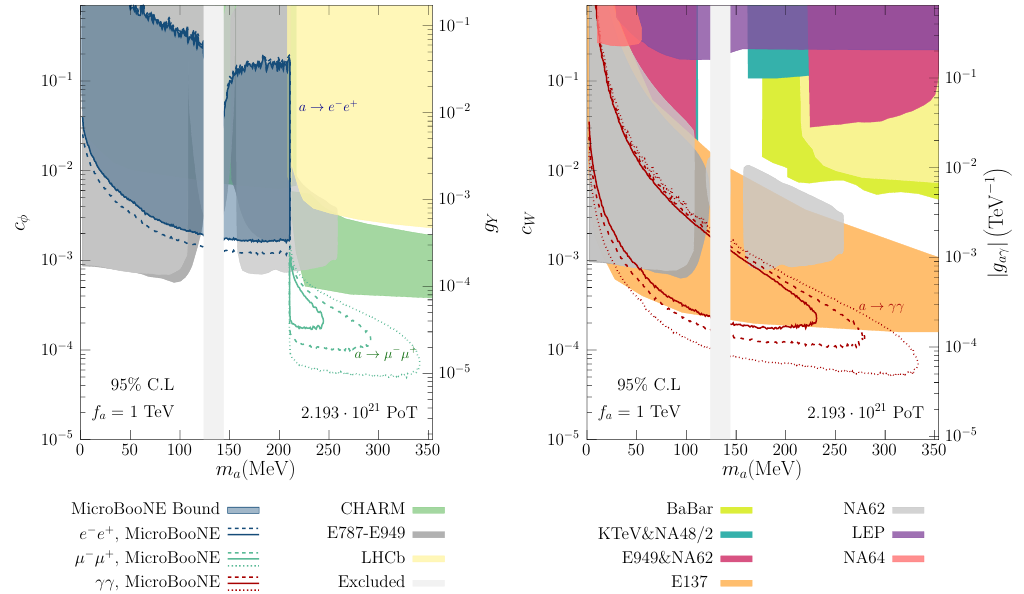
Figure 3 . MicroBooNE sensitivity projections, for c φ (left panel) and c W (right panel) as a function of m , assuming f = 1 TeV, for N = 2 . 2 × 10 21 . The regions enclosed by the colored lines a a PoT satisfy ∆ χ 2 > 3 . 84 , corresponding to 95% CL for 1 degree of freedom (d.o.f.). Results are shown separately for the decay channels with the largest branching ratios in each case: a → γγ , a → e + e − and a → µ + µ − , as indicated by the labels. Solid lines assume σ = 0 . 89 and σ = 0 . 3 ; dashed lines s b assume σ = σ = 0 . 2 ; and dotted lines indicate the no-background limit, taking σ = 0 . 2 (see text s b s for details). The shaded areas show current bounds from BaBar [38], E137 [24, 25], NA62 [21,